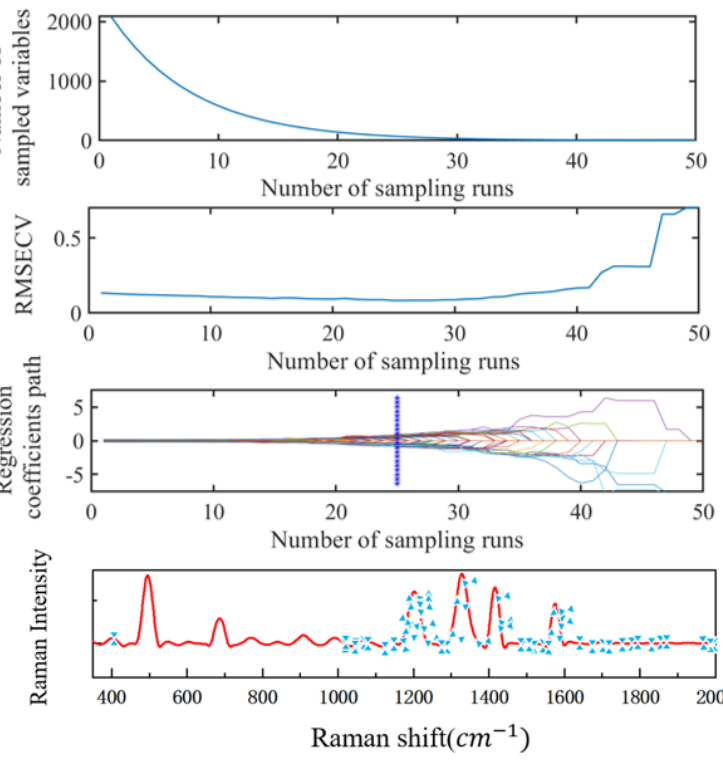
Figure 8. Example of running result of SCARS algorithm.